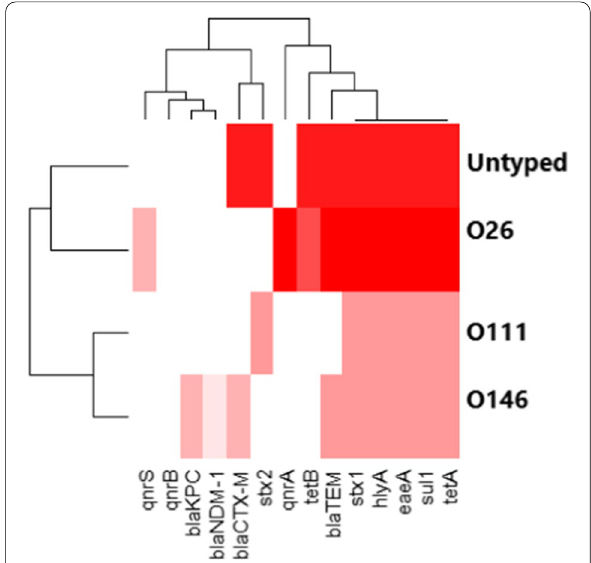
Fig. 4 The heat map shows the correlation between virulence genes, the antimicrobial‑resistance genes, and the retrieved STEC